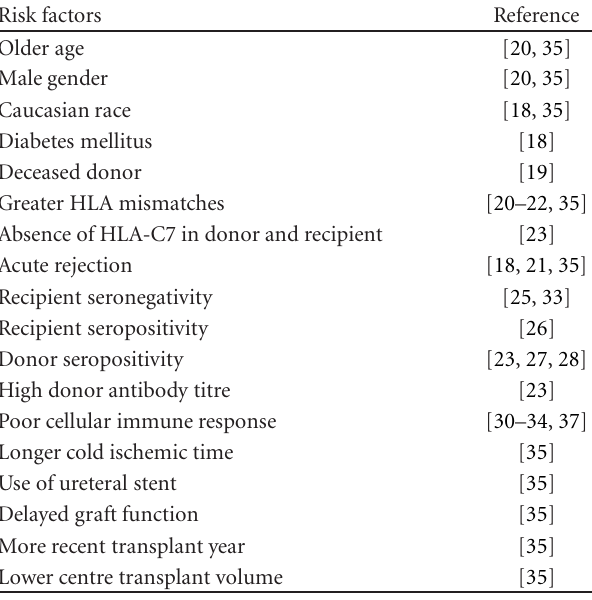
Table 1: Factors other than immunosuppression associated with increased risk of posttransplant BKV